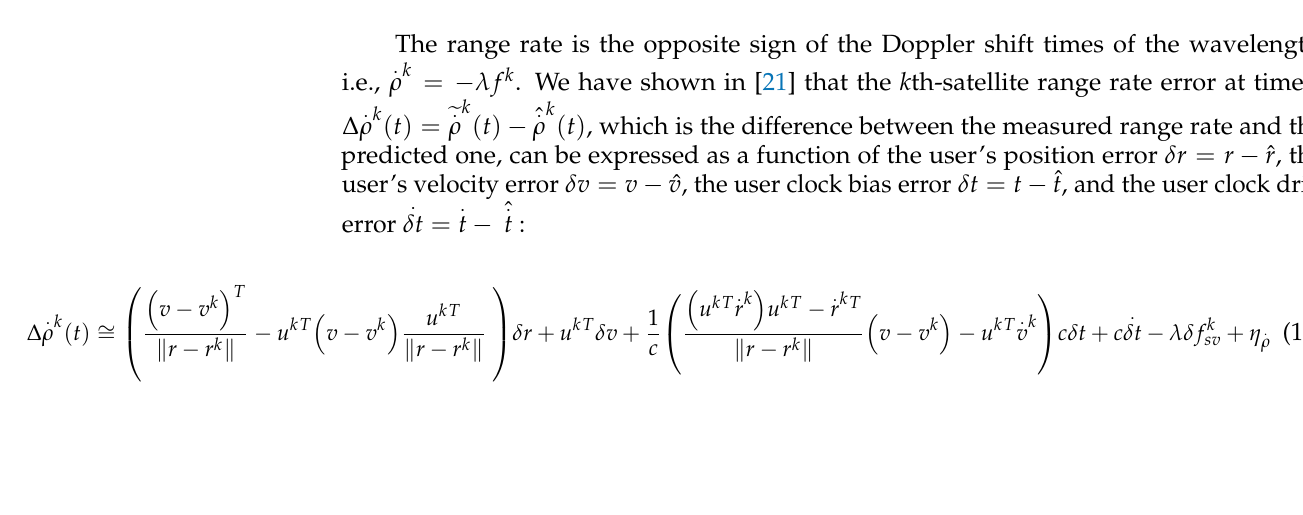
Figure 11. A block diagram showing the processing steps used to perform positioning from Starlink downlink tones.